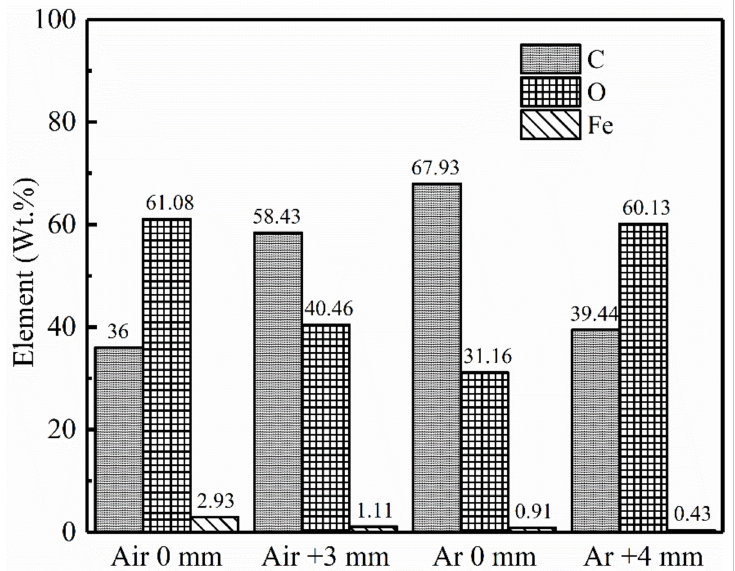
Figure 17. Content of C, O and Fe elements of particles collected by silicon wafers. 1st group: in ambient air, focusing; 2nd group: in ambient air, defocus distance +3 mm; 3rd group: in inert atmosphere, no defocusing; 4th group: in inert atmosphere, defocus distance +4